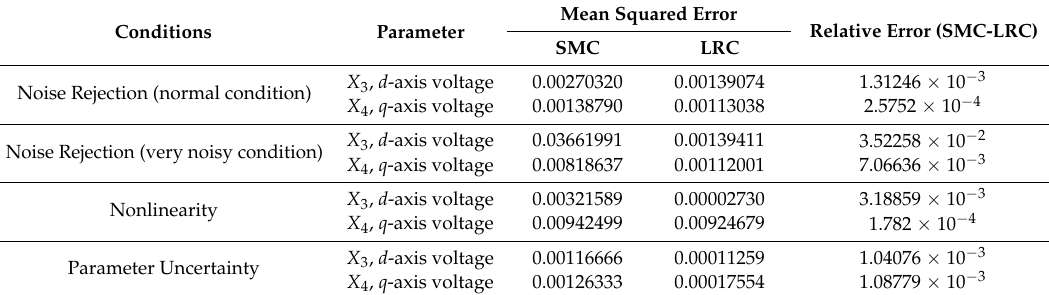
Figure 13. Comparison of performance among SMC (colored in blue) and LRC (colored in green) in case of ( a ) d -axis control input current, I d ( u 1 ); ( b ) q -axis control input current, I q ( u 2 ) considering CPL power variation and parametric uncertainties. LRC fluctuated less than SMC, causing less stress on the system and thus providing a longer lifetime. Table 2. Mean squared error (MSE) values of SMC and LRC controllers for the different conditions.